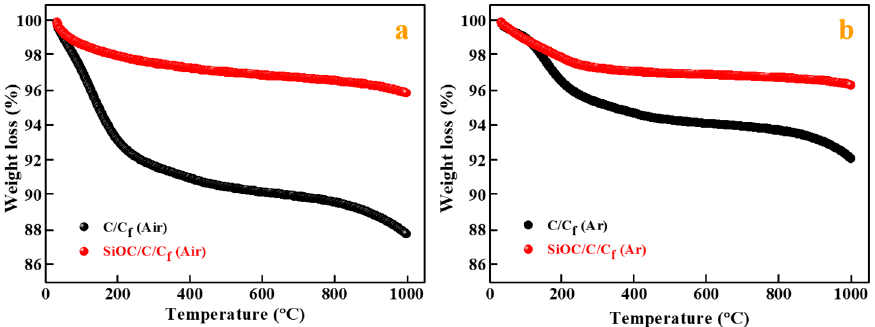
Figure 7. TGA curves for the as-prepared composites with three PIP cycles and composites without silicon oxycarbide (SiOC) ceramic from room temperature to 1000 °C under ( a ) air and ( b ) Ar atmospheres.